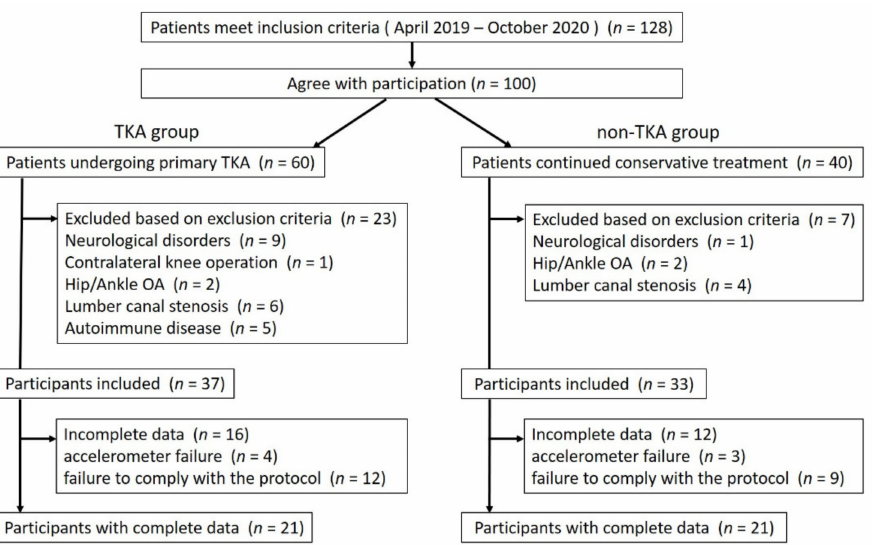
Figure 1. Flowchart of patient selection in this study. Abbreviations: TKA, total knee arthroplasty; OA,